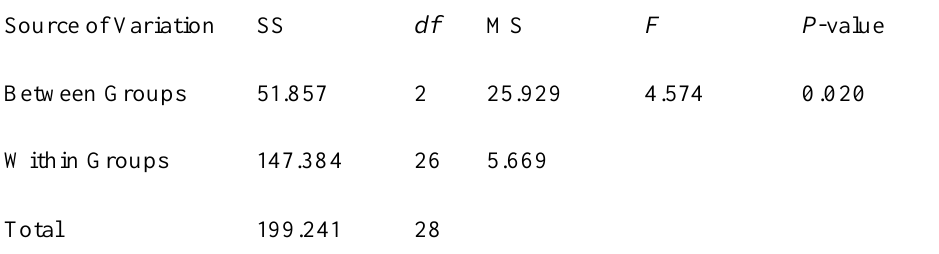
Single Factor ANOVA on Number of Student Postings by SM Size ANOVA Source of Variation